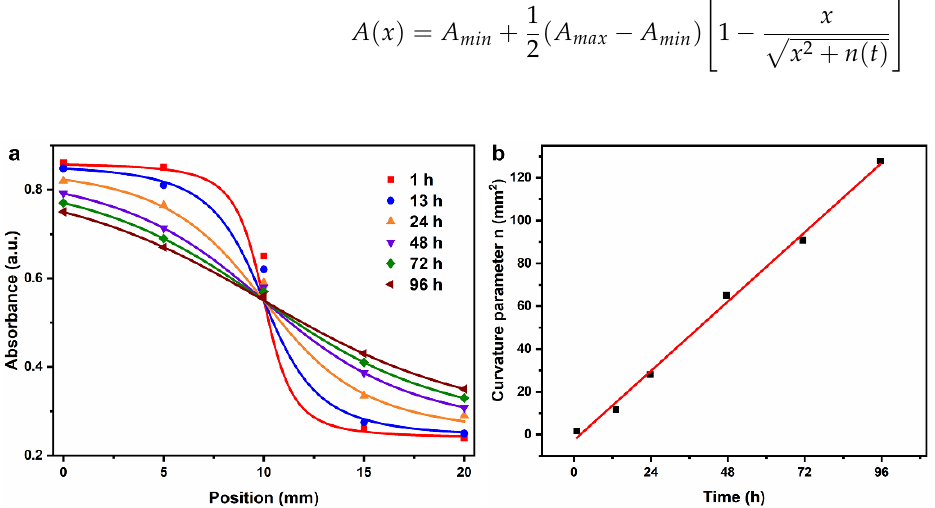
Figure 8. ( a ) Absorbance of Fe 3+ -XO complex of FPX dosimeter at different positions as a function of time after irradiation. ( b ) Linear fitting of curvature parameter to time after irradiation.